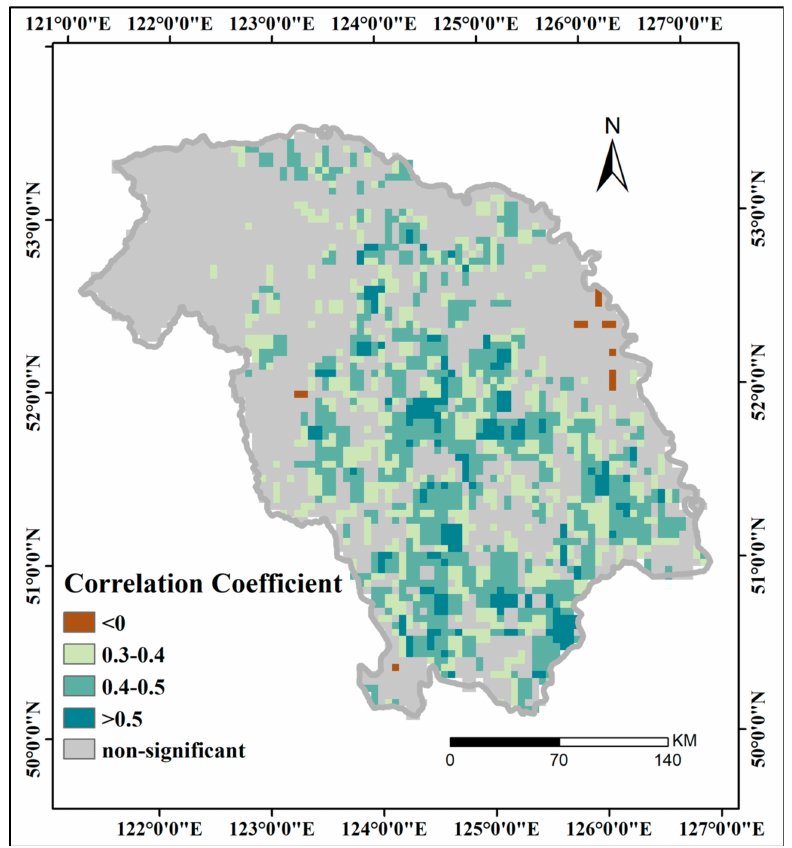
Figure 8. Correlation coefficient between GSL and AGG in the GKM during 1982–2014. (Green indicates significant positive correlation (r > 0, p < 0.05), brown indicates significant negative correlation (r < 0, p < 0.05), and gray indicates non-significant correlation ( p >